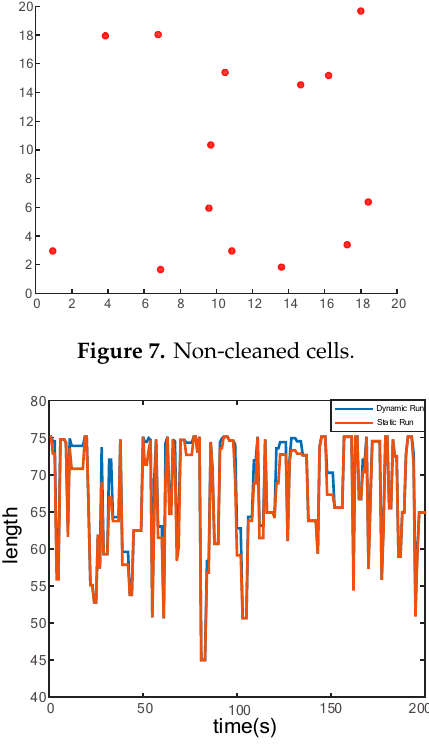
Figure 8. Curves on optimal path length determined by both algorithms.